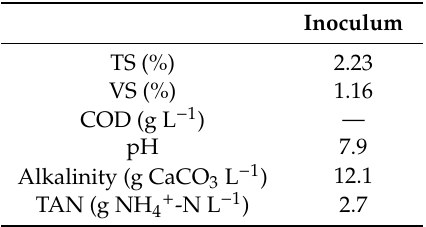
Table 2. Characteristics of the inoculum used in the study (TS and vs. are expressed as a percentage of the total